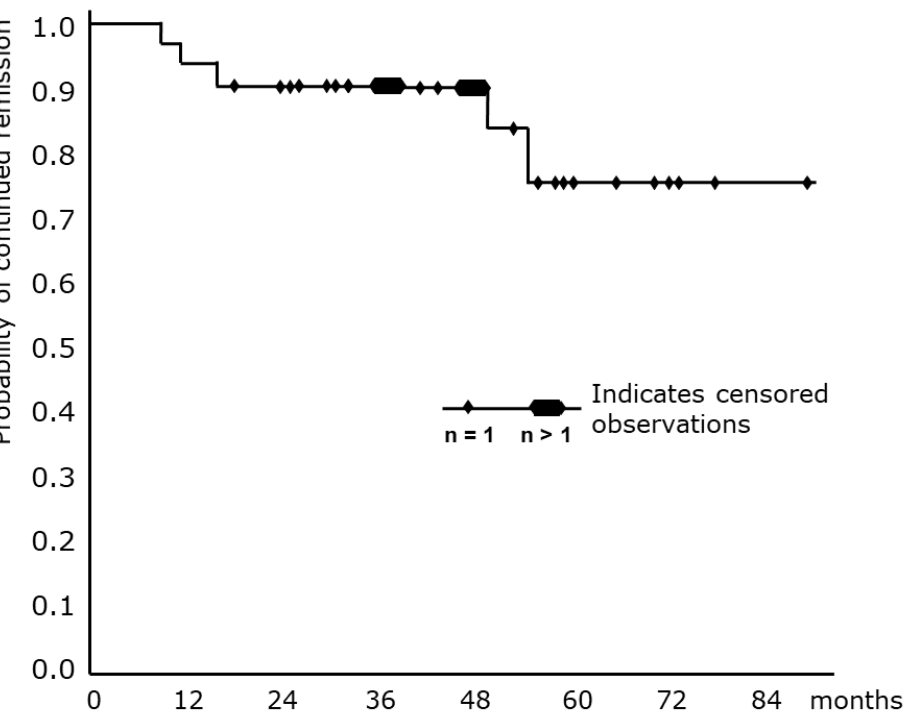
Figure 5. Probability of sustained remission in patients who have responded to 4 cycles of rituximab plus bendamustine. Kaplan–Meier plot. Median response duration is not reached after 88 months and the estimated 5-year sustained response rate is 77%. Figure first published in Blood 2020 [26], reused under general permission. © the American Society of Hematology.